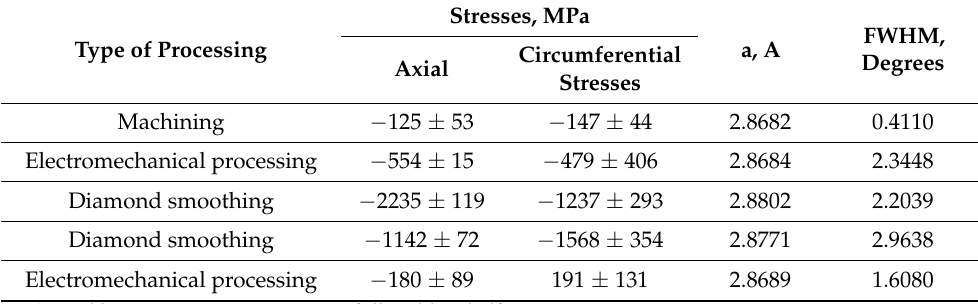
Table 1. Macrostresses and structural characteristics of various areas of